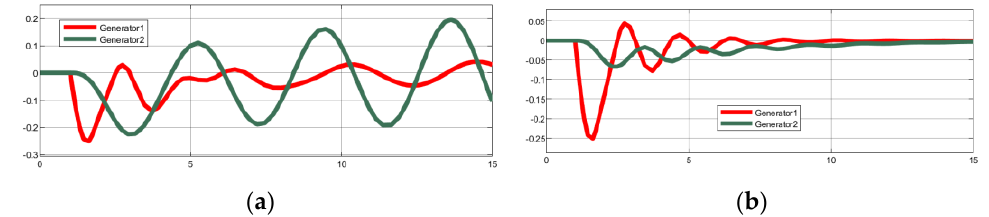
Figure 7. ( a ) Frequency Deviations, Case 1. ( b ) Frequency Deviations, Case 2.